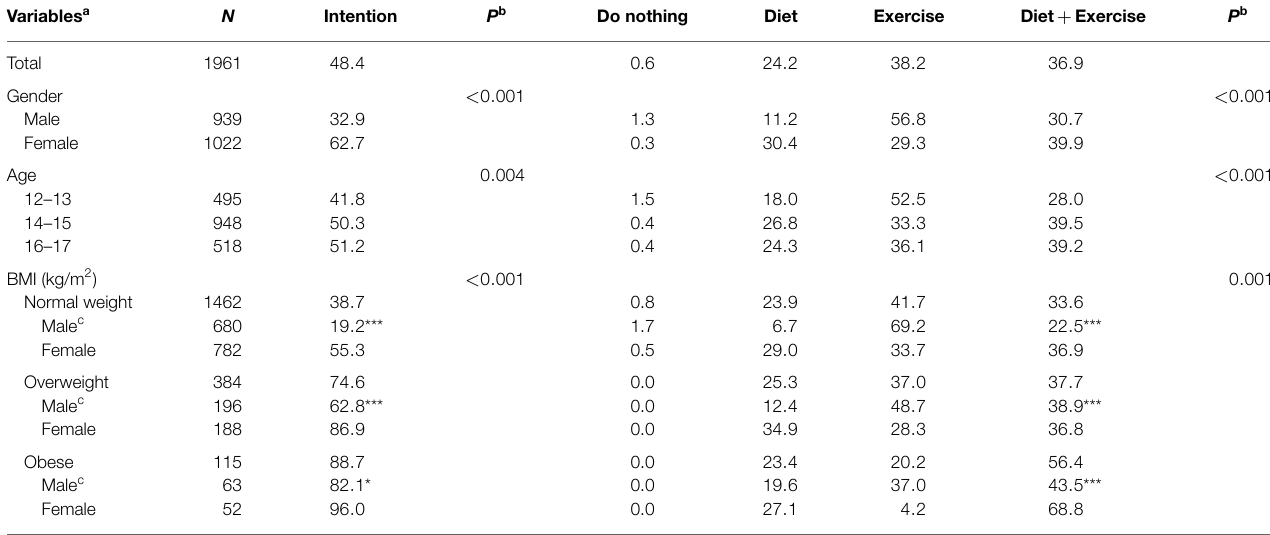
TABLE 3 | Influence of gender, age, and gender within each BMI group on the intention to lose weight and the start of diet and/or exercise